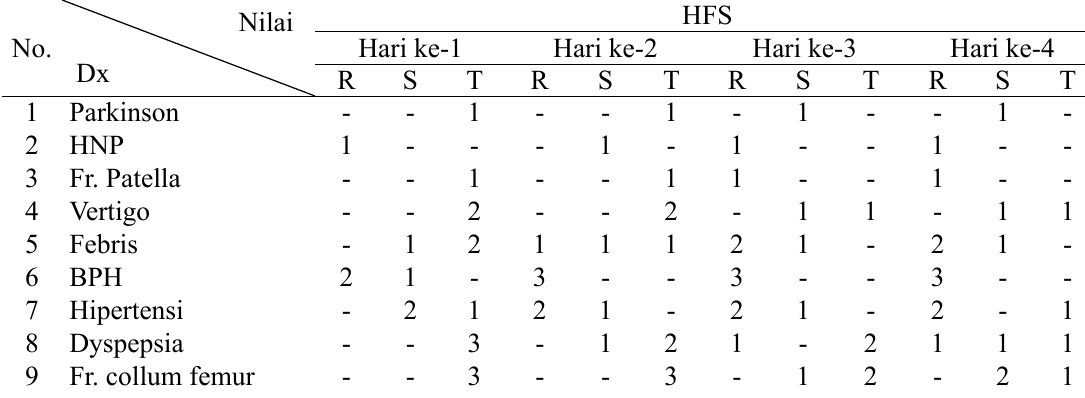
Tabel 6. Penilaian risiko jatuh dengan instrumen HFS berdasarkan diagnosis medis di ruang perawatan